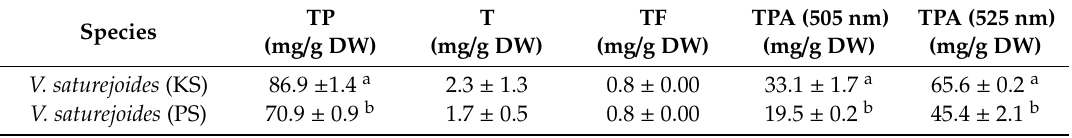
Table 3. Contents of total polyphenols (TP), total tannins (T), total flavonoids (TF), and total phenolic acids (TPA) in V. saturejoides